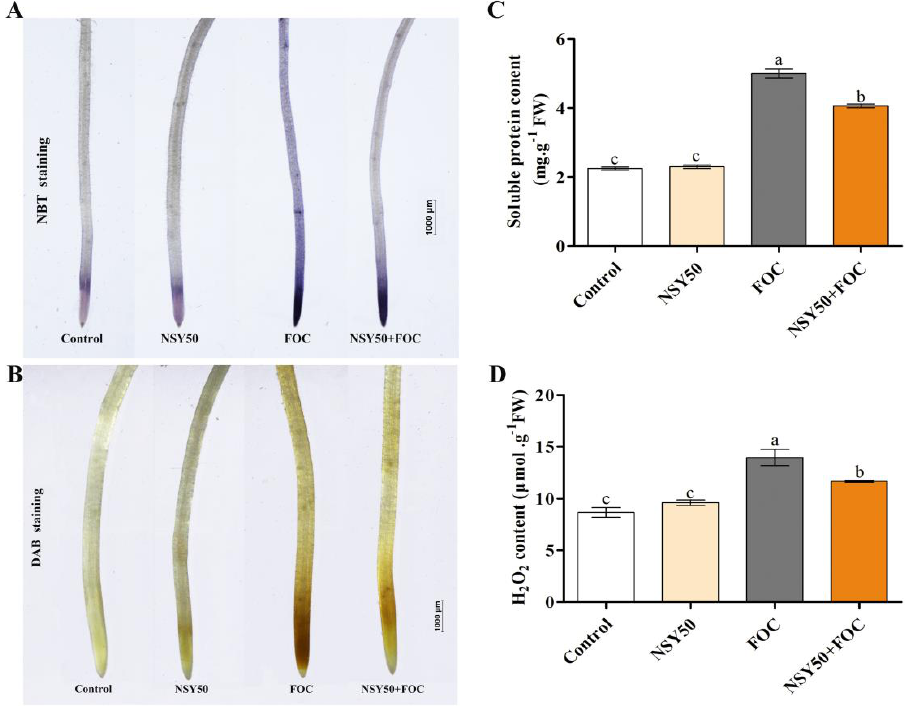
Figure 3. Effects of NSY50 on oxidative damage and soluble protein content in cucumber roots under Fusarium wilt stress at 3 days post-inoculation. ( A ) Histochemical staining by nitroblue tetrazolium (NBT) of O 2.- , ( B ) Histochemical staining by 3, 3-Diaminobenzidine (DAB) of H 2 O 2 , ( C ) Soluble protein contents. ( D ) H 2 O 2 contents. Values are the means ± SD, n = 3 (biological replicates), and different letters (a > b > c) indicate a significant difference at p < 0.05, as determined by Duncan’s multiple-range